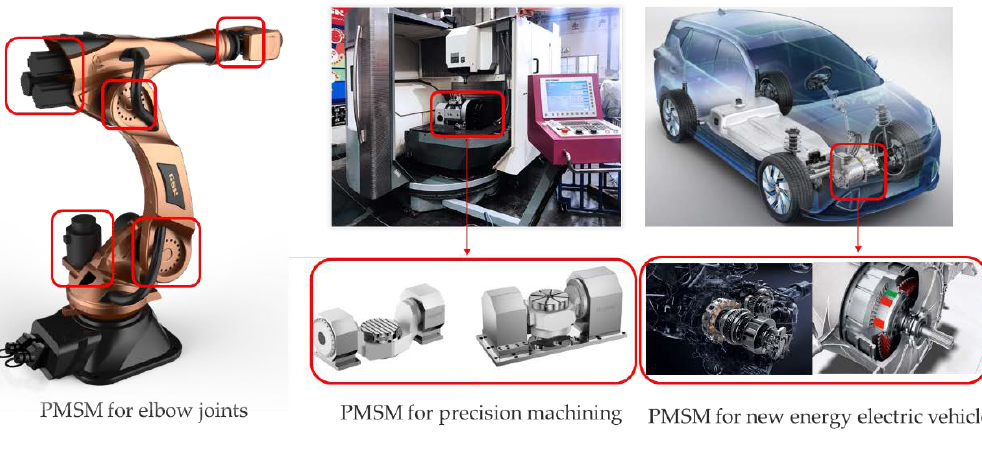
Figure 1. Typical applications of permanent magnet synchronous motors in the environmental energy industry: ( a ) robots; ( b ) high-precision servo equipment; ( c ) new energy electric vehicles.